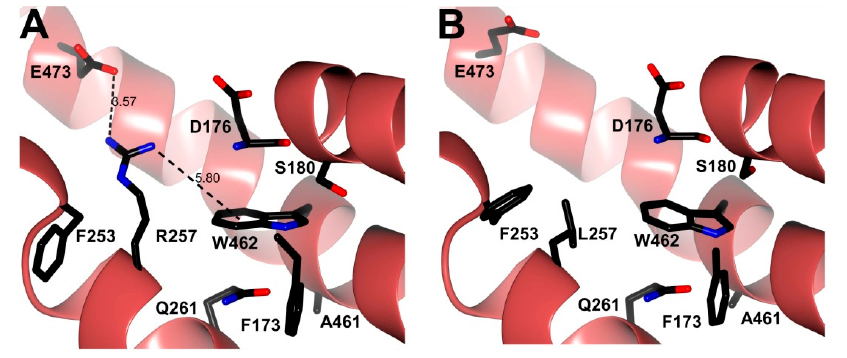
Figure 9. Cont. Figure 9.